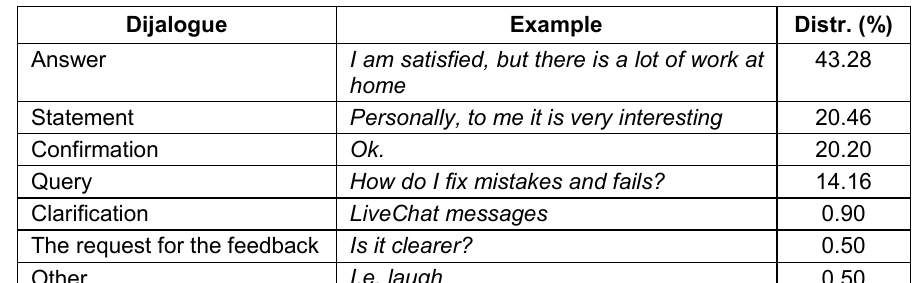
Table 2 – Students’ dalogues, their features, sample statements and frequency of their occurrence Таблица 2 – Диалог слушателей курса , характеристики , выражения лица и частотность их появления Tabela 2 – Dijalog slušalaca kursa, karakteristike, uzorak iskaza i frekvencije